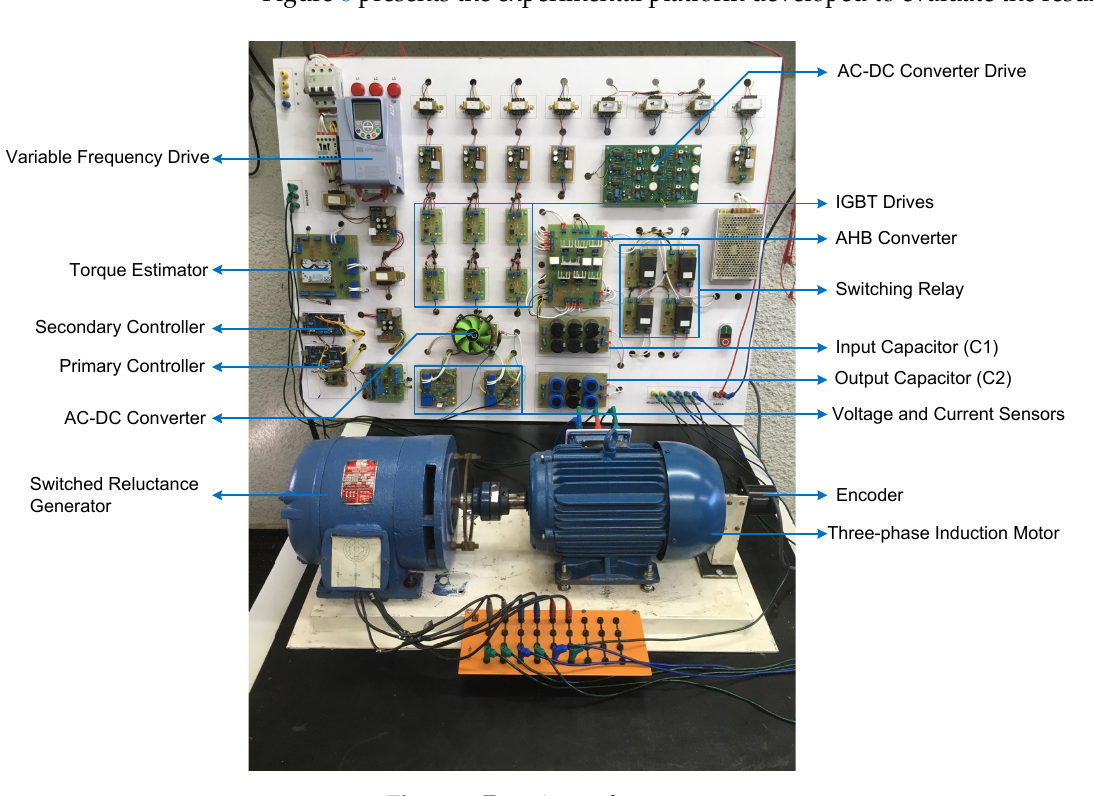
Figure 6. Experimental